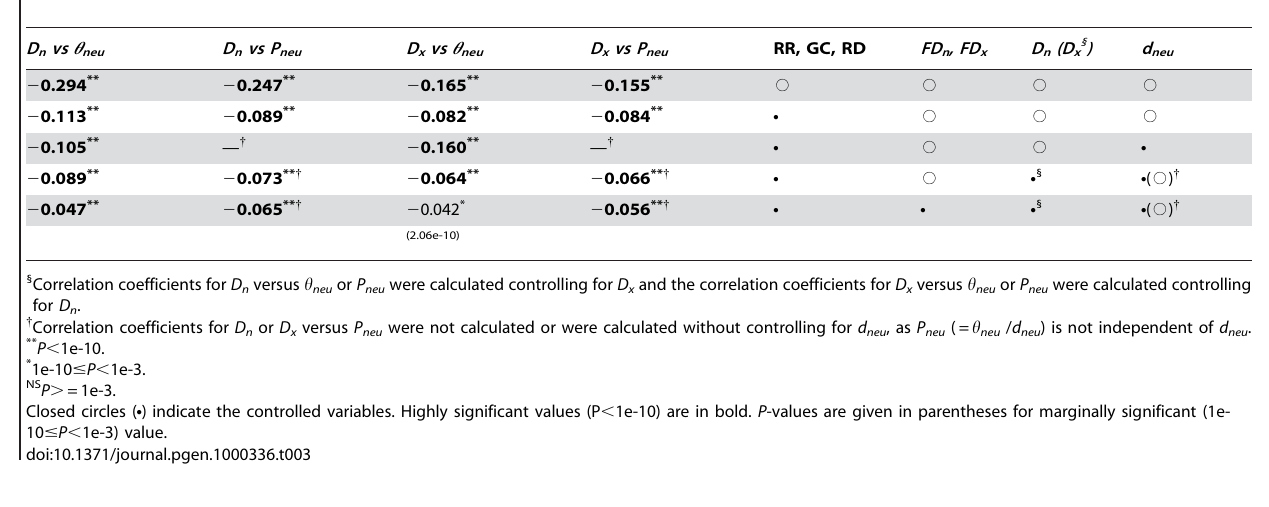
Table 3. Spearman rank correlation and partials correlation coefficients between the divergence at coding sites ( D n ) and the levels of neutral polymorphism ( h neu ) or normalized neutral polymorphism ( P neu = h neu / d neu ) and between the divergence at conserved noncoding region ( D x ) and the levels of neutral polymorphism ( h neu ) or normalized neutral polymorphism ( P neu = h neu / d neu ).